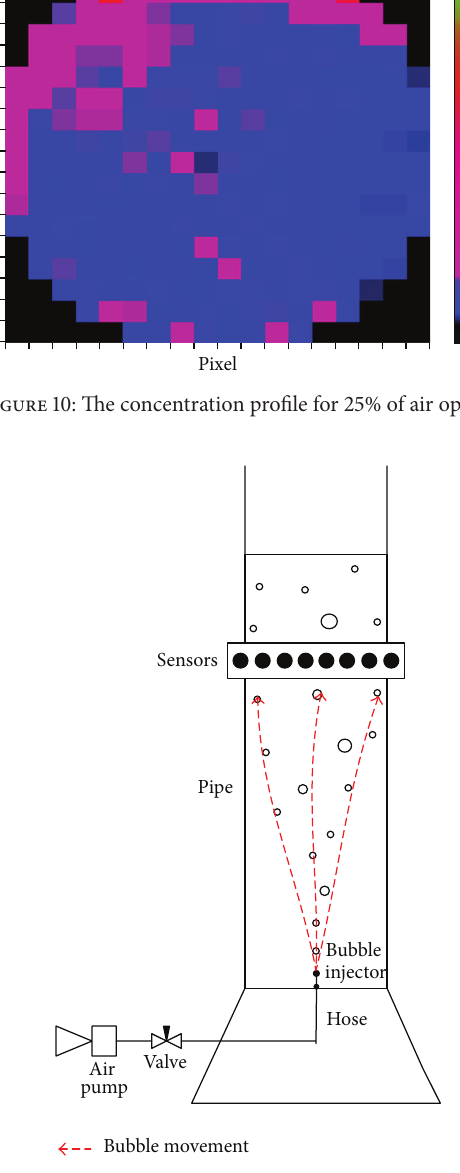
Figure 11: Bubbles movement upwards from the